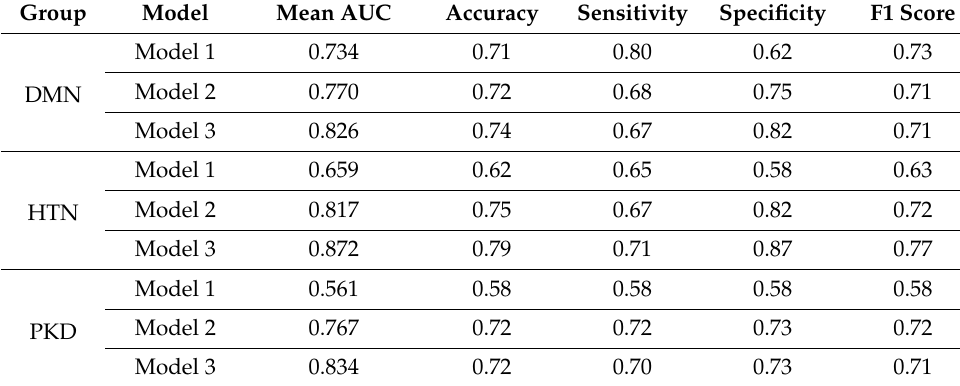
Table 3. Classification performance metrics for each predictive